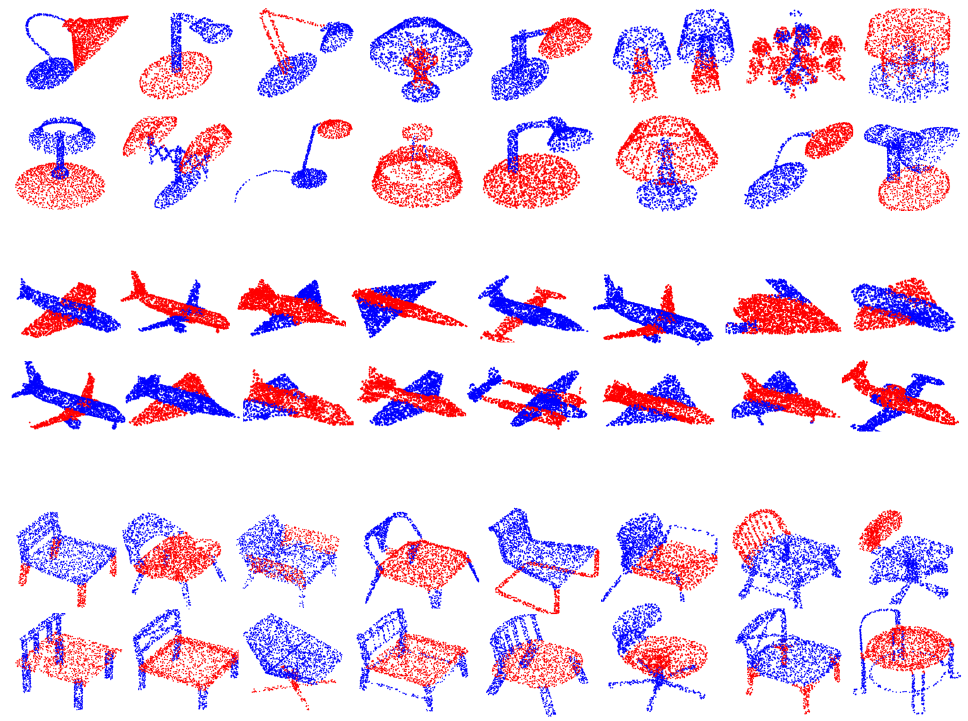
Figure 4. Visualization of the part segmentation results for the lamps, airplanes and